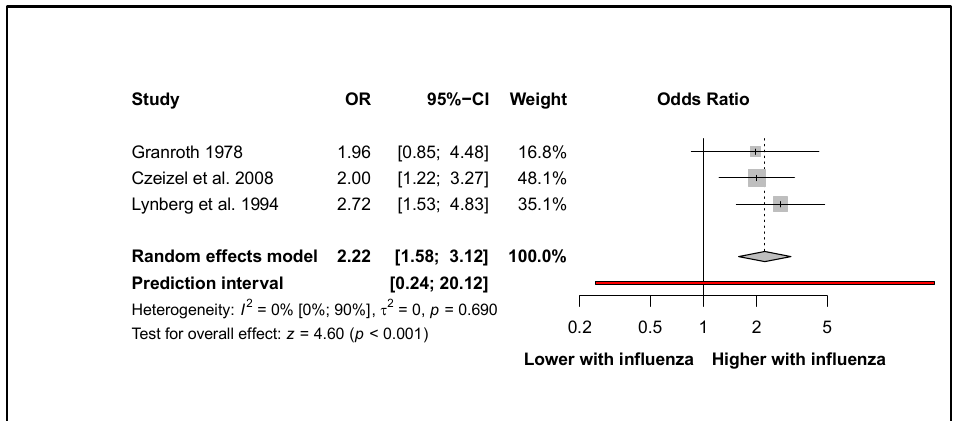
Figure 3. The odds of developing spina bifida after influenza infection in the first trimester [34–36]. Two studies provided data for the assessment of encephalocele. Czeizel et al.